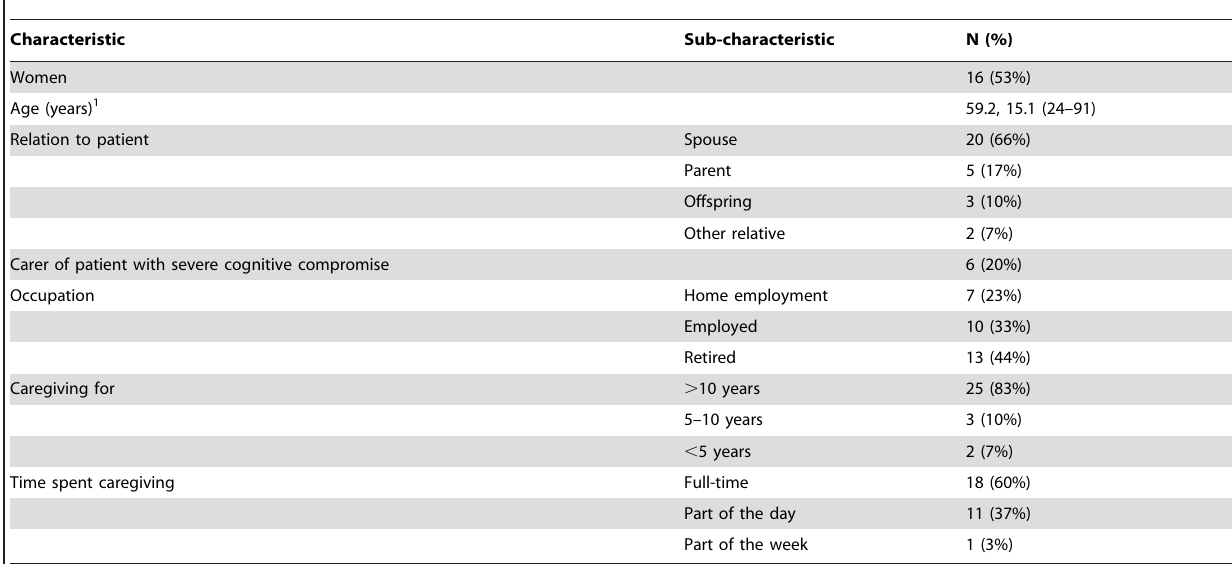
Table 2. Characteristics of the 30 carers who participated in the focus group meetings.